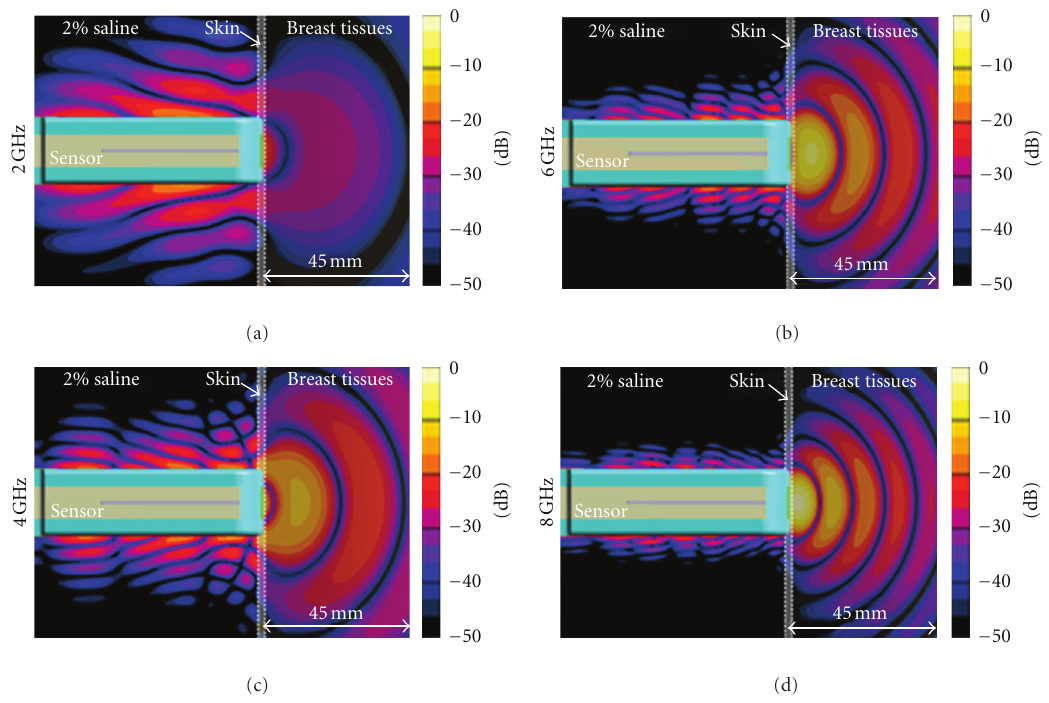
Figure 8: Electric field radiated by the antenna in realistic breast tissues while immersed in 2% saline. All field intensities are normalised to identical input power. The side-on view is shown (i.e., the cross-section through the cylindrical breast model is along its long axis).